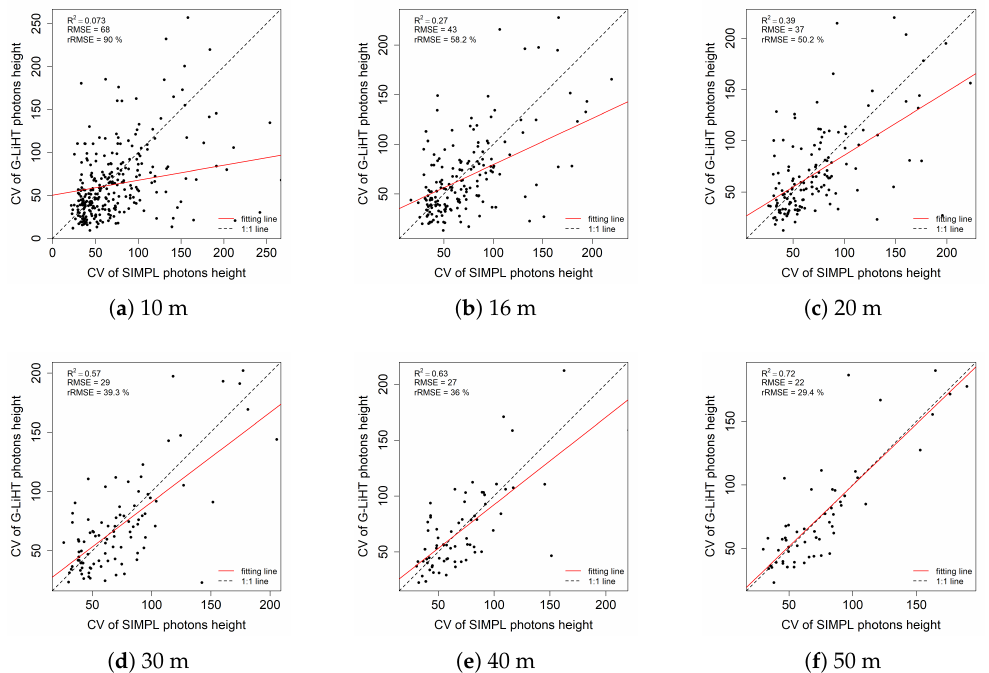
Figure 14. The relationship between the coefficient of variation of all photon heights from SIMPL and the coefficient of variation of all return heights from G-LiHT for different scales.